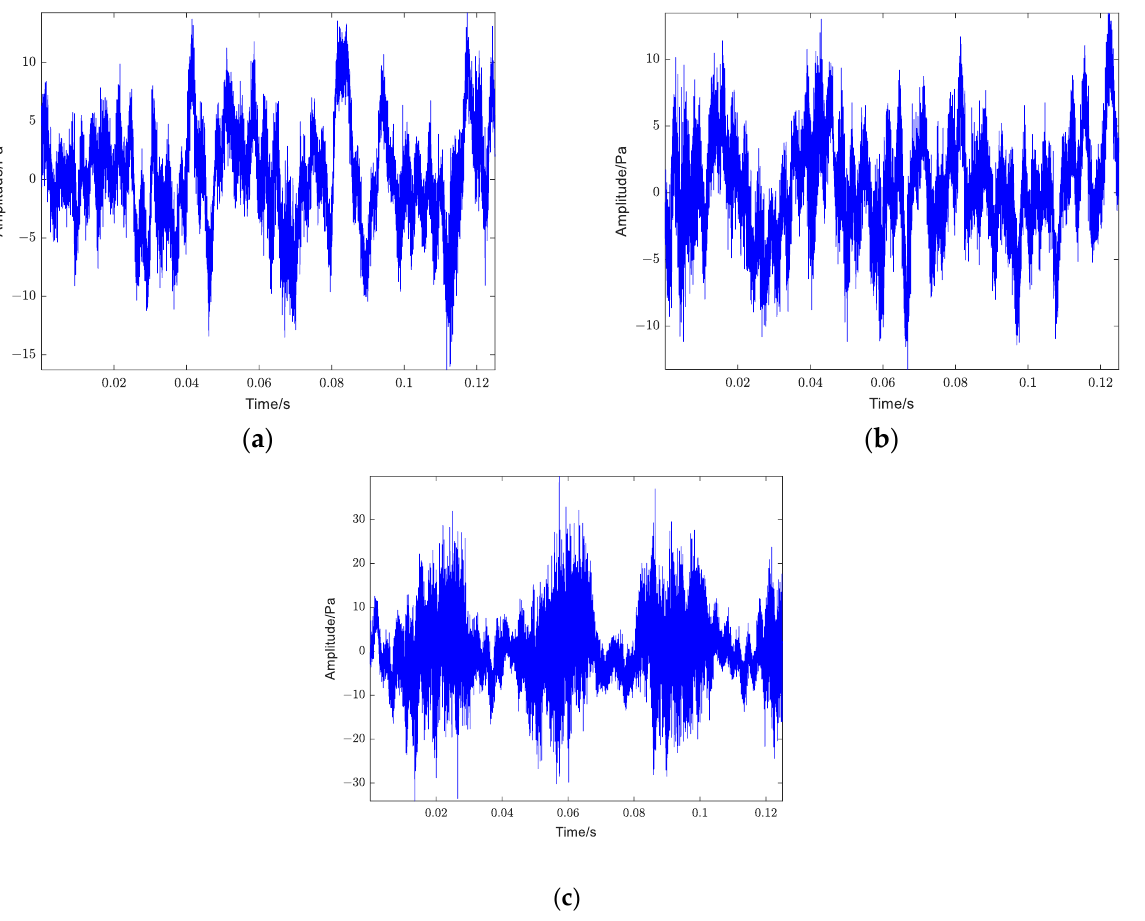
Figure 8. Original time domain diagram of propeller noise signal collected under three test conditions: ( a ) no cavitation; ( b ) cavitation inception; ( c ) full cavitation.